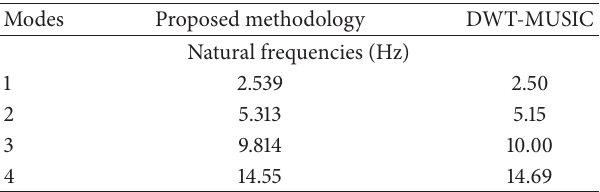
Table 3: Identified natural